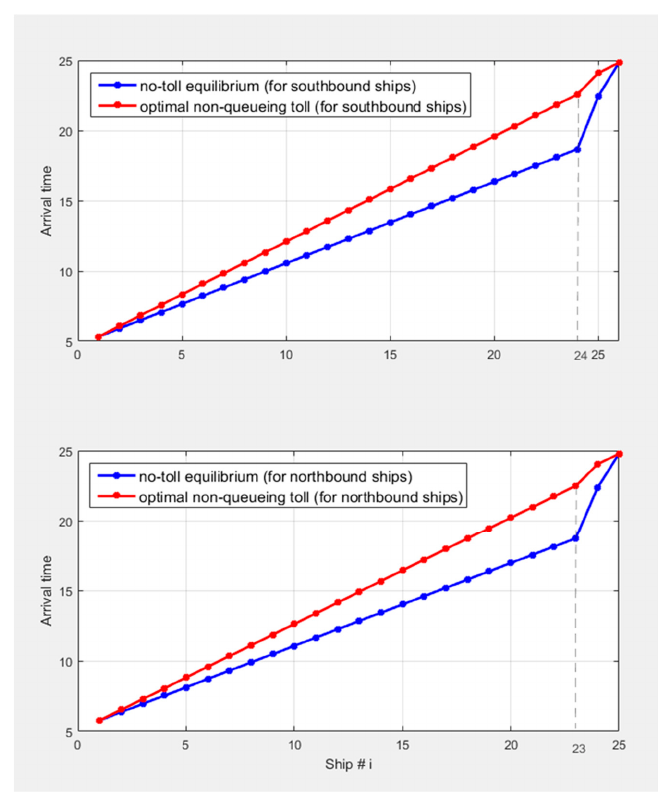
Figure 3. Numerical results of arrival time adjustment for southbound (SB) and northbound (NB) ships from the no-toll to the tolled case.